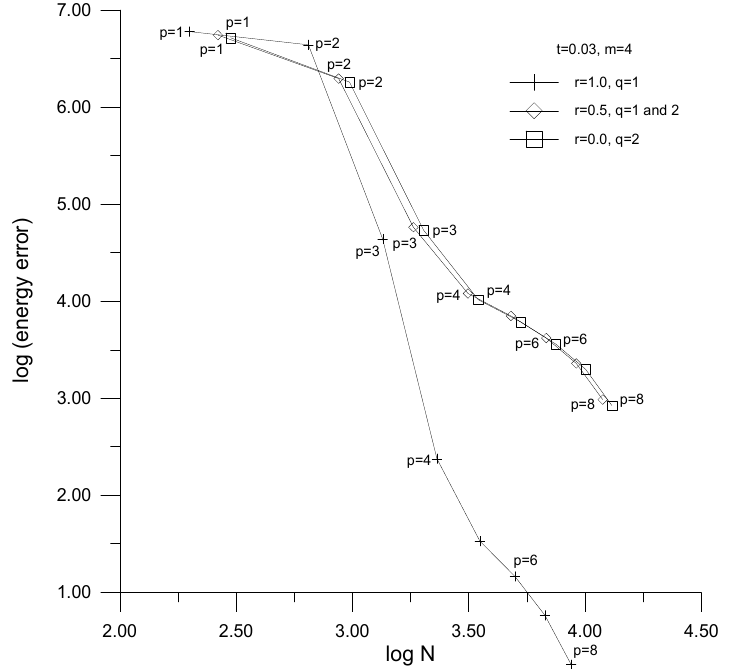
Figure 20. Convergence curves—the plate problem, the classical transition elements